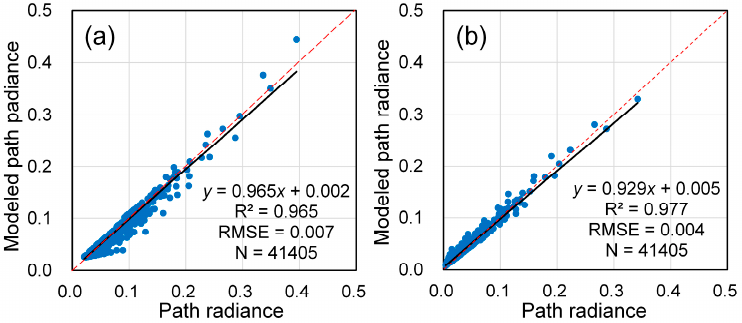
Figure 2. Comparisons of the calculated path radiances (6S model) and the estimated path radiances (analytical model) in ( a ) the red and ( b ) the near-infrared bands.